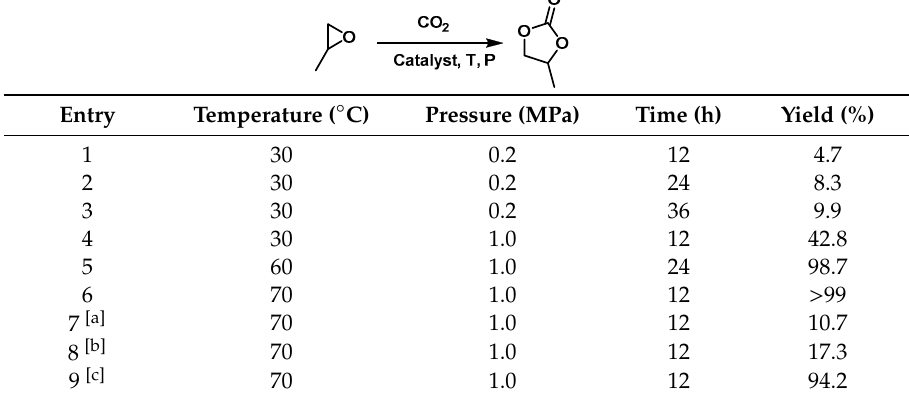
Polymers 2019 , 11 , x FOR PEER REVIEW